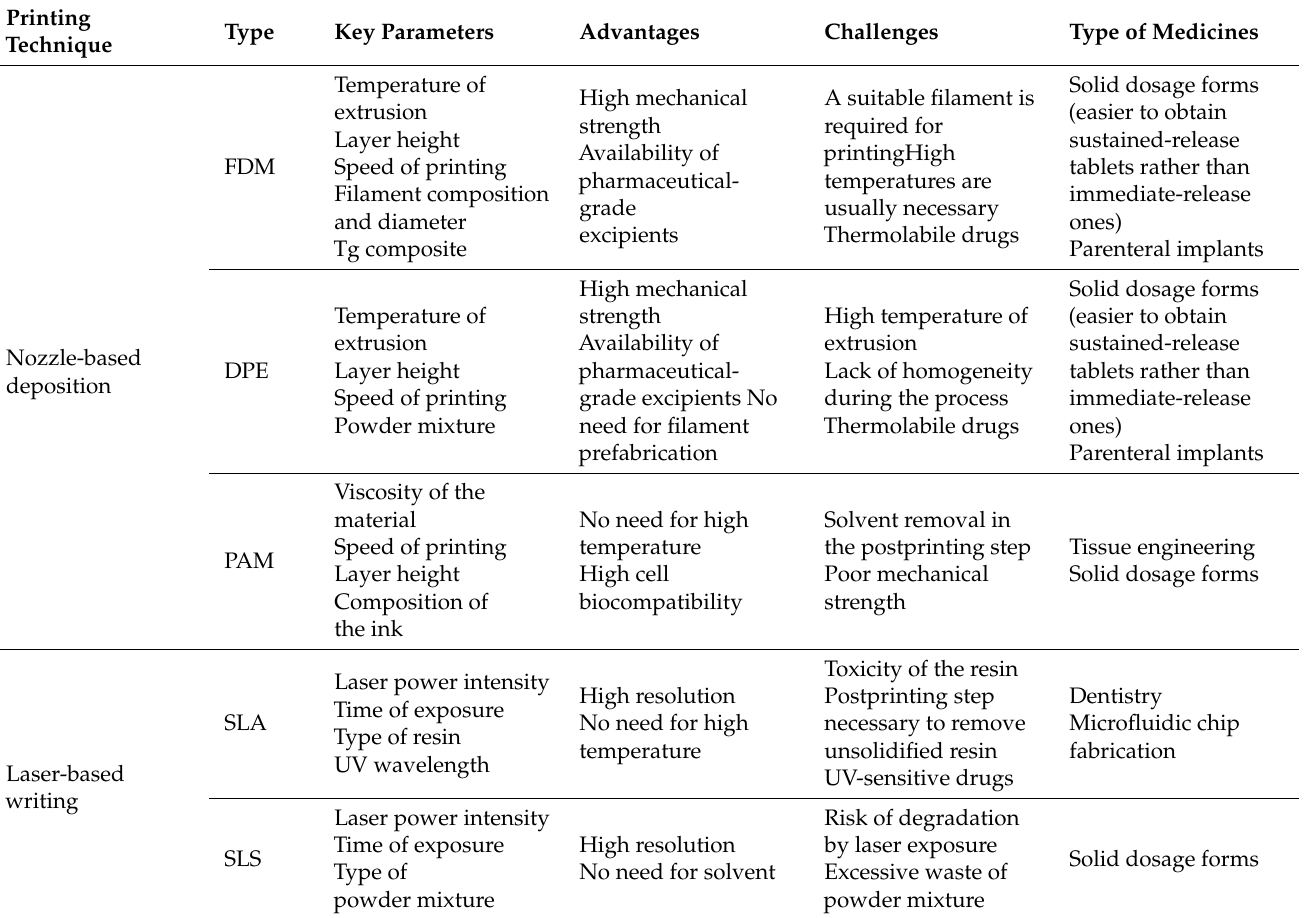
Table 1. Comparison of 3D printing techniques utilised for the fabrication of personalised medicines. FDM, fuse deposition modelling; DPE, direct powder extrusion; SSE, semisolid extrusion; PAM, pressure-assisted microsyringes; SLA, stereolithography; SLS, selective laser sintering; Tg, glass transition